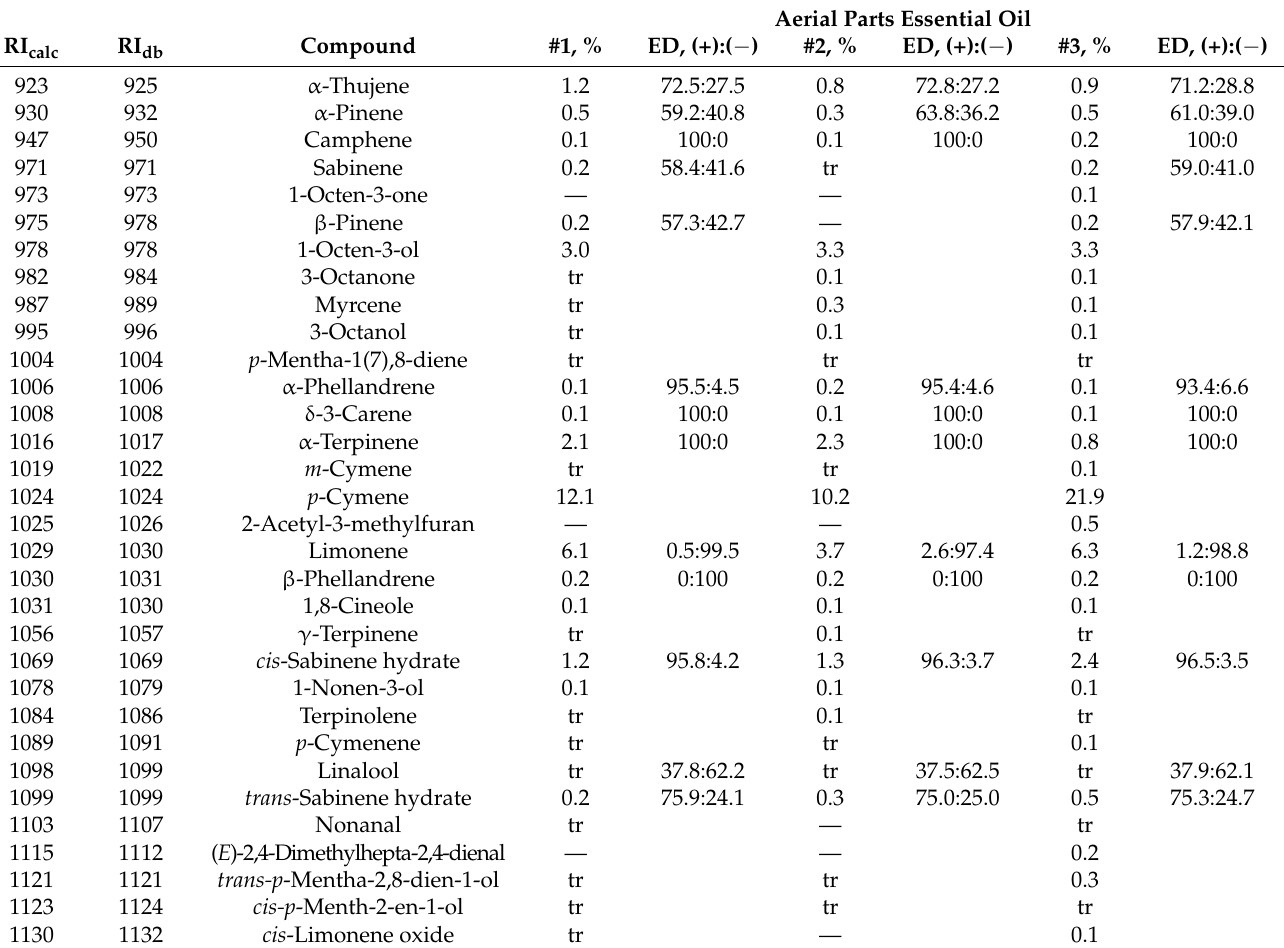
Table 2. Chemical composition of Monarda fistulosa essential oils cultivated in south Alabama.